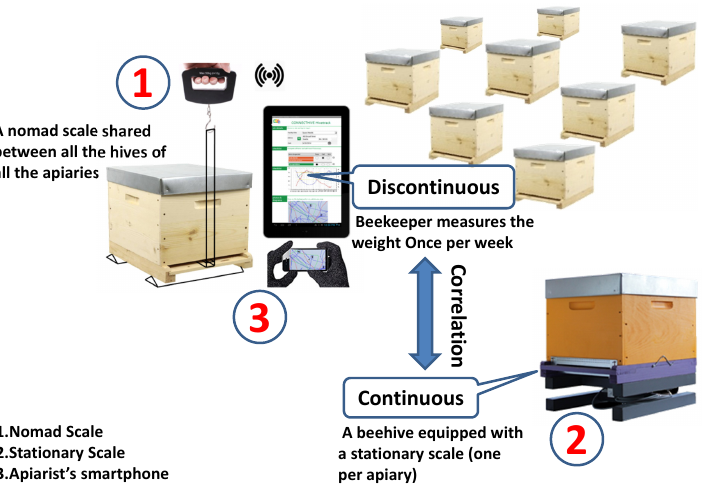
Figure 3. Continuous and discontinuous weight